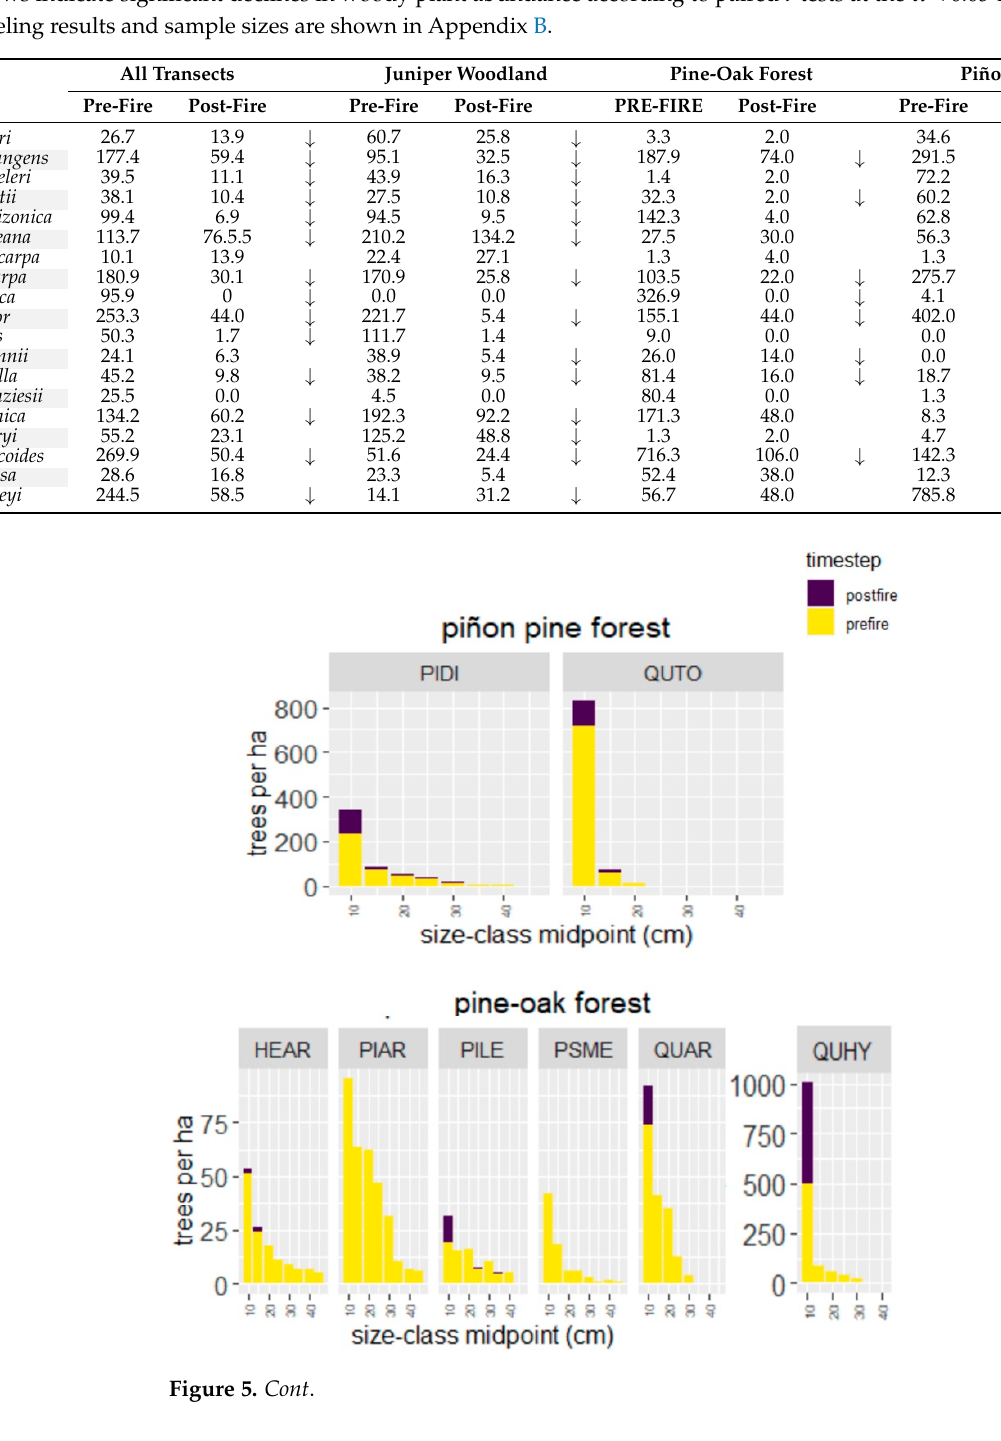
Figure 5. Mean size class distributions (# ha − 1 ) in 5-cm size classes for the pre-fire (yellow) and post-fire (purple) samples for dominant tree species in the three major vegetation types in Chiri- cahua National Monument, Arizona. All tree species experienced significant declines in tree spe- cies abundances in size classes < 20 cm diameter at breast height. Full t-test model results are shown in Appendix C. 4. Discussion The results demonstrate the effects of a contemporary wildfire that burned with mixed effects on Madrean Sky Island vegetation. Fire severity, elevation, and topography regulated the effects of the Horseshoe Two Fire on woody plant community composition